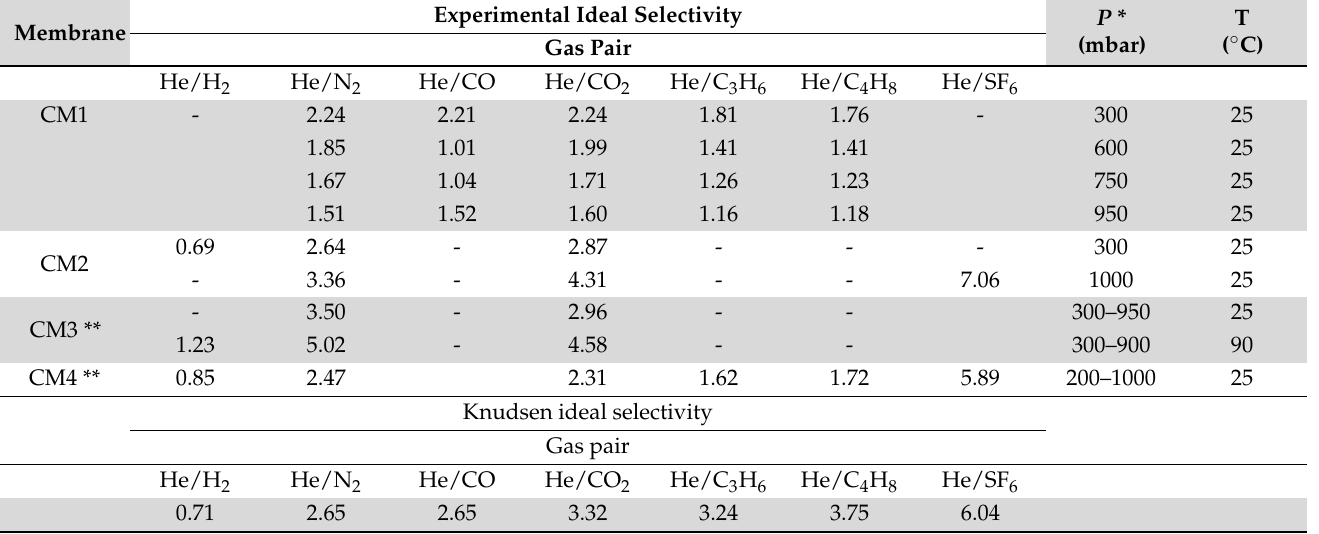
Table 4. Experimental ideal selectivity values for the pairs of single gases H 2 , N 2 , CO, CO 2 , C 3 H 6 , C 4 H 8 , and SF 6 with helium, for the studied membranes CM1to CM4, at the applied pressures and temperatures, in comparison to the respective Knudsen ideal selectivity